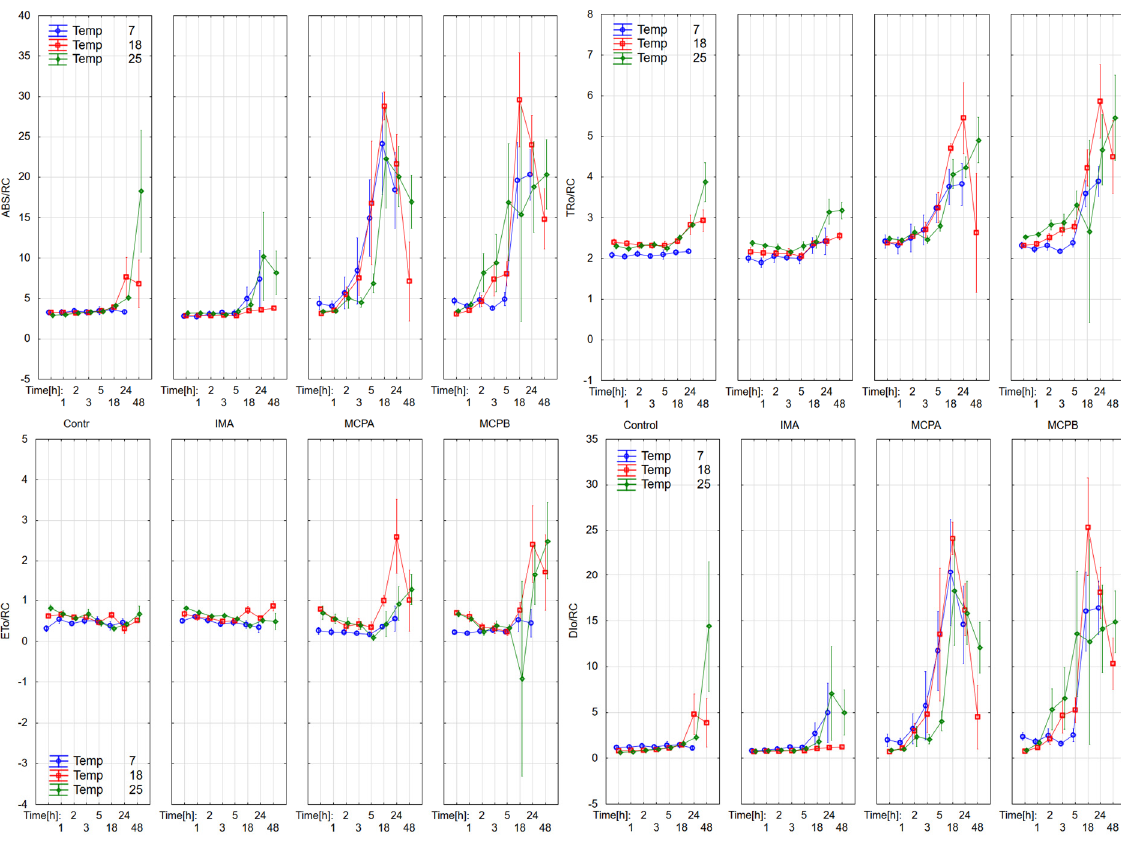
Figure 5. Time course of the performance index (PI_abs) after the application of herbicides (MCPA, MCPB and IMA) on Galea orientalis cultivated at three different temperatures (7, 18 and 25 °C). The parameters related to the processes of absorbed energy conversion in PSII, i.e.,